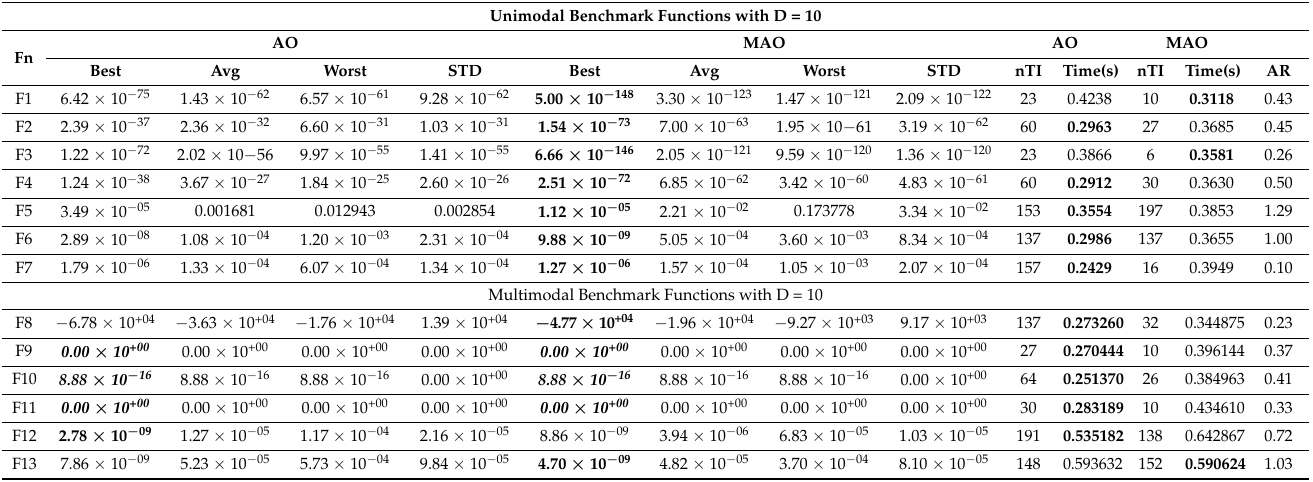
Table 5. Results obtained for unimodal and multimodal functions with D = 10. Unimodal Benchmark Functions with D =